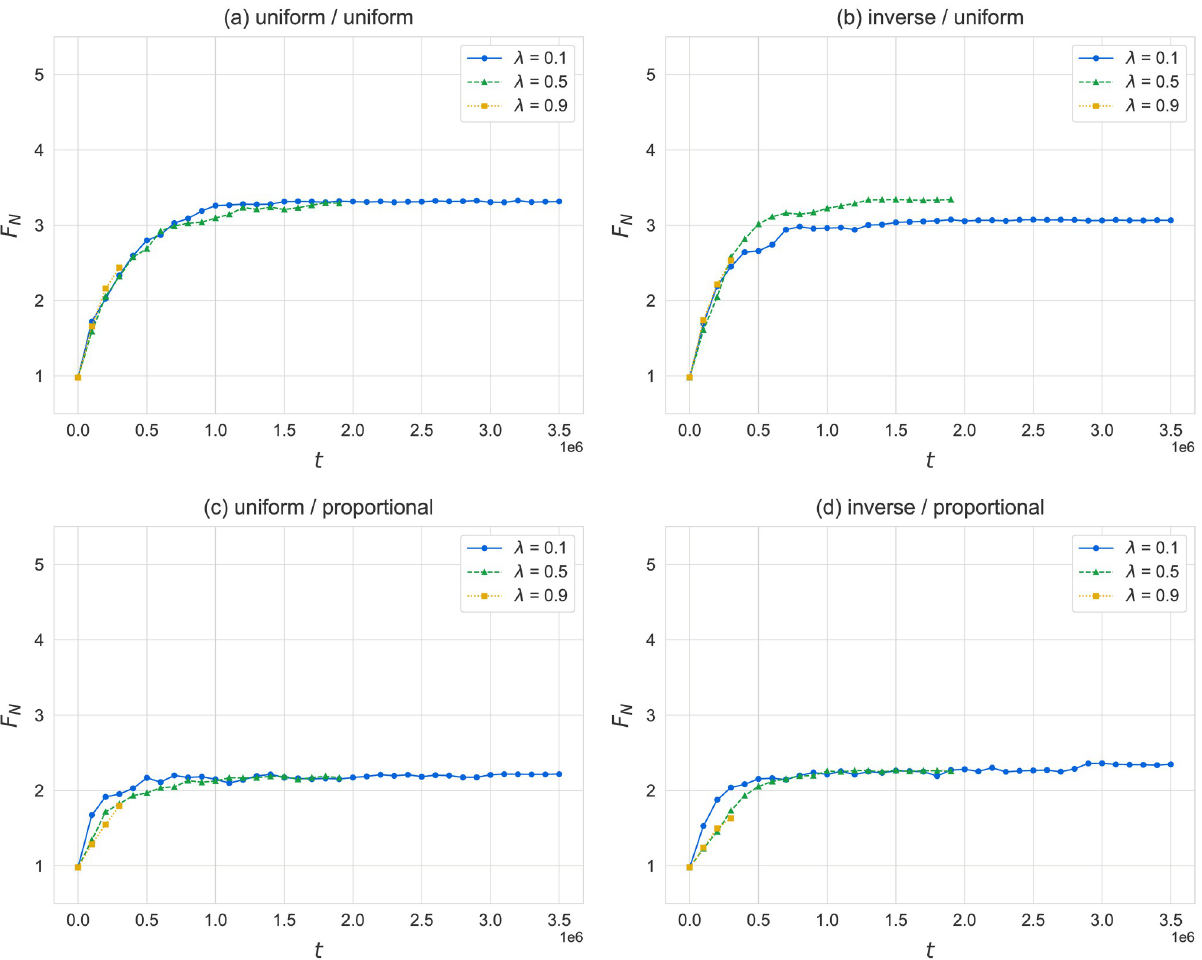
Fig 9. Effects of different rewiring rules and rewire probability λ on average payoffs F N . We show (a) uniform disconnection and uniform reconnection, as a base case; (b) fitness-inverse disconnection and uniform reconnection; (c) uniform disconnection and fitness-proportional reconnection; and (d) fitness-inverse disconnection and fitness-proportional reconnection (see previous section for definition of these rewiring rules.) Three different values of λ are shown for each configuration of rewire rules: 0.1, 0.5, and 0.9. The x-axis is normalized for the number of reproduction events. Simulation complexity and limits on computational resources did not allow us to simulate all cases for an equal number of reproduction steps. Results are for random networks and N = 400, with neighbor influence δ = 0.5, averaged over 16 runs.